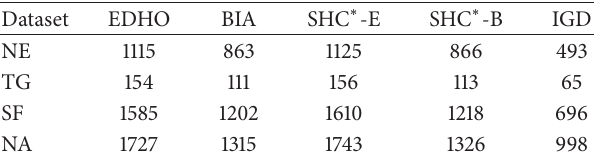
Table 3: Estimation